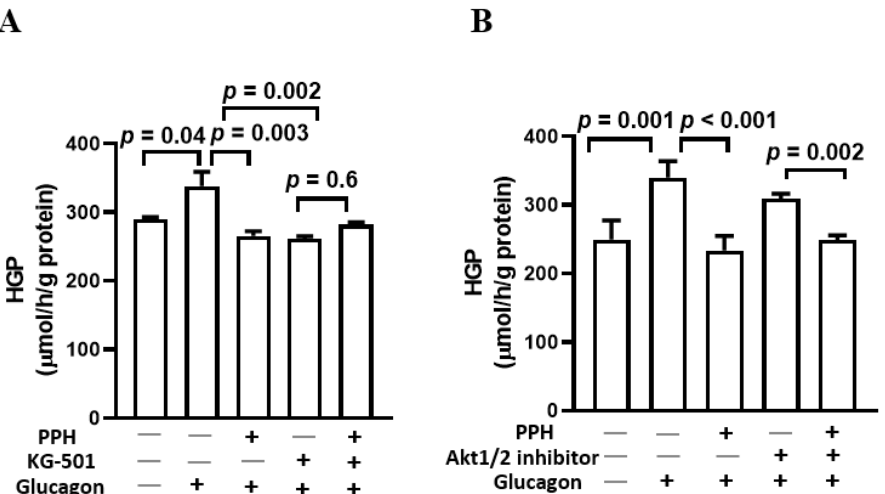
Figure 6. PPH suppressed glucose production in the AML-12 cells via the glucagon signaling but not the insulin signaling . AML-12 cells were cultured in glucose and phenol red-free DMEM containing sodium pyruvate and sodium lactate and pre-treated PPH and 10 µ M of KG-501 ( A ) or 1 µ M of Akt1/2 inhibitor ( B ) for 1 h, followed by the co-treatment with glucagon (100 nM) for 6 h. The concentration of glucose produced by the cells was normalized by the total protein content of the cells. Data are expressed as mean ± SEM of 5 independent experiments.